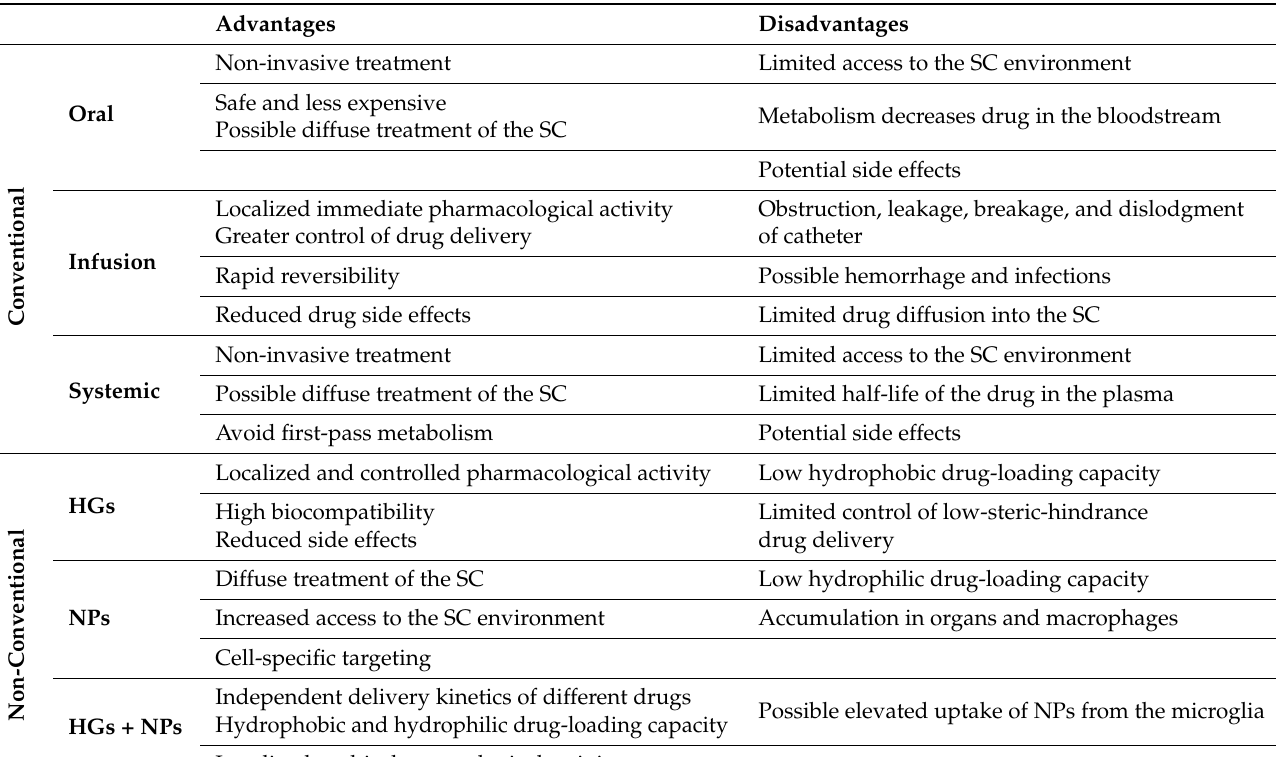
Table 1. Advantages and disadvantages of the conventional and non-conventional treatments discussed in this